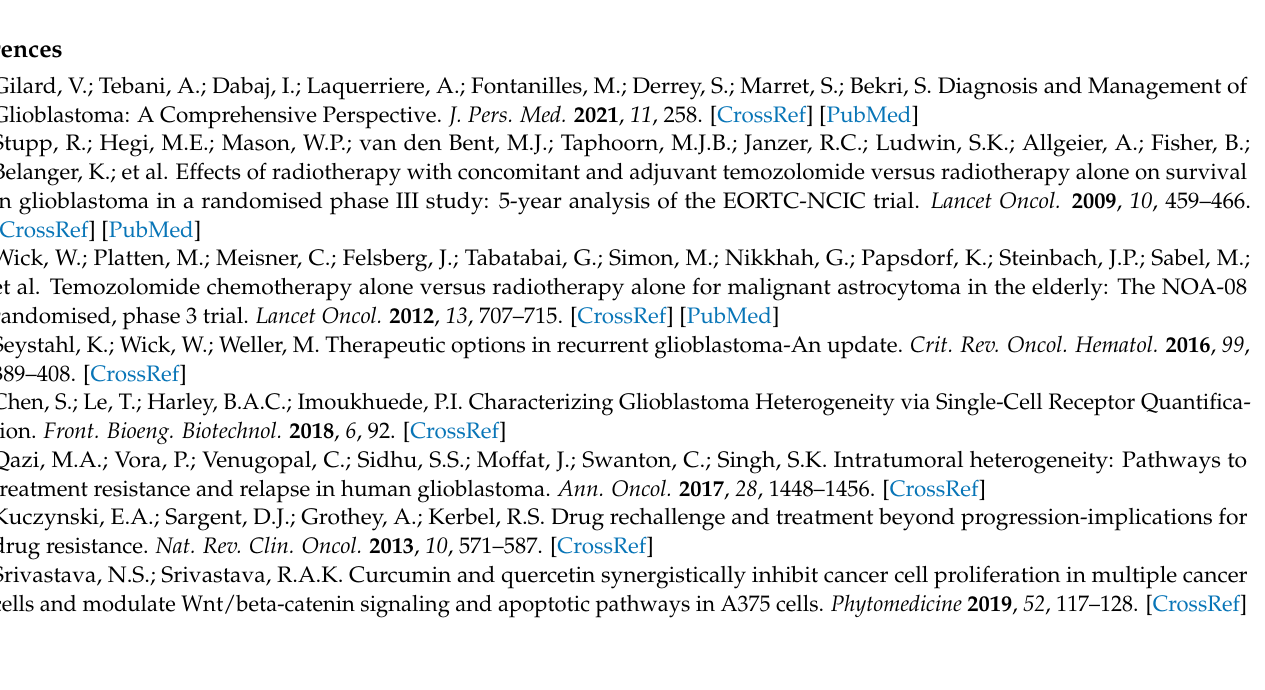
and BBR-S solubility in different organic solvents; Figure S1. Spectra of sodium laurate (a) and sodium dodecyl sulfate (b). Figure S2. Flow cytometric characterization of NPS. NPs (i.e., L, LF, S, and SF) were analyzed by flow cytometry (Amnis Imagestream, Luminex). (A) High-gain-mode acquisition with 60 × magnification was applied to plot particle distribution according to their size (Area_M04/Aspect Ratio Intensity), thus defining R1 and R2 gates. (B) Examples of NP image galleries within the indicated gates—channels are reported with BBR signals (BF = bright field; SC = size scatter). Figure S3. TEM ultrastructural analysis of NPs. NPs (i.e., L, LF, S, and SF) were visualized on a Zeiss EM900 electron microscope (Zeiss) operating at 80 kV. Scale bars = 100 nm. Figure S4. DSC profiles of NPs loaded with BBR-L (a) and BBR-S (b). Figure S5. Clonogenic evaluation of the BBR-loaded NPs on T98G cells. First, 103 growing cells were treated with 107 of each NP formulation for 24 h; then, after media replacing, cells were cultivated for an additional 2 weeks in 6-well plates. Colonies were then stained with blue-methylene and evaluated for their numbers and distribution. Figure S6. Optical microscope examination of NPs’ effect on rat normal astrocytes. NPs without BBR (B, blank), with BBR DS (S), with or without LED stimulation (4 min light stimulation) were administered (10 7 particles) for 24 h and analyzed using Nikon TS100 optical microscope at 10 × and 40 × magnification. Figure S7. In vitro BBR-L and BBR-S release profile from